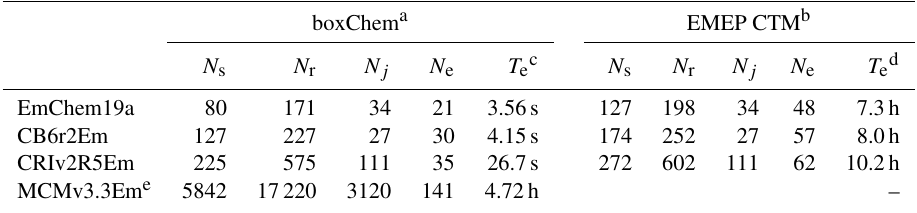
Table 3. Comparison of chemical mechanisms provided with GenChem 1.0, in either boxChem (mainly gas phase) or EMEP CTM (with many particle and semivolatile compounds and tracers) configurations: number of species ( N s ), number of rate coefficients, ( N r , including photolysis), number of photolysis reactions ( N j ), number of anthropogenic emission terms ( N e ) and computer execution time ( T e ) for example run.